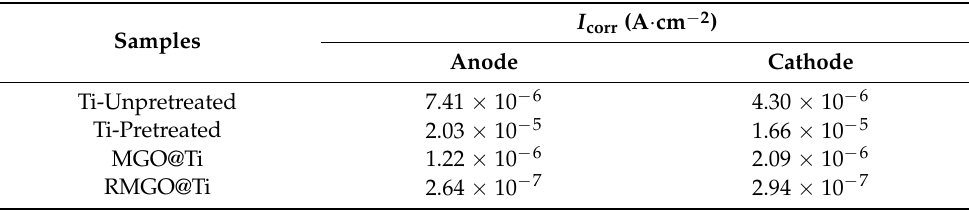
Table 2. Potentiostatic I corr of the samples in the simulated PEMFC